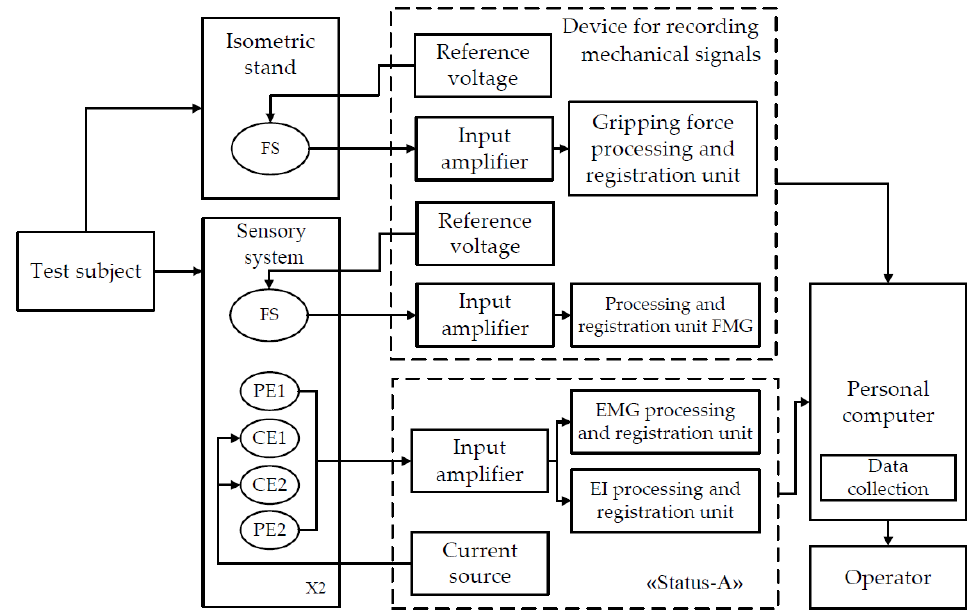
Figure 5. The layout of the laboratory hardware and software complex for simultaneous acquisition of EI, EMG, and FMG signals (FS, force sensor; PE, potential electrode; CE, current electrode). Table 1. Technical parameters of the laboratory